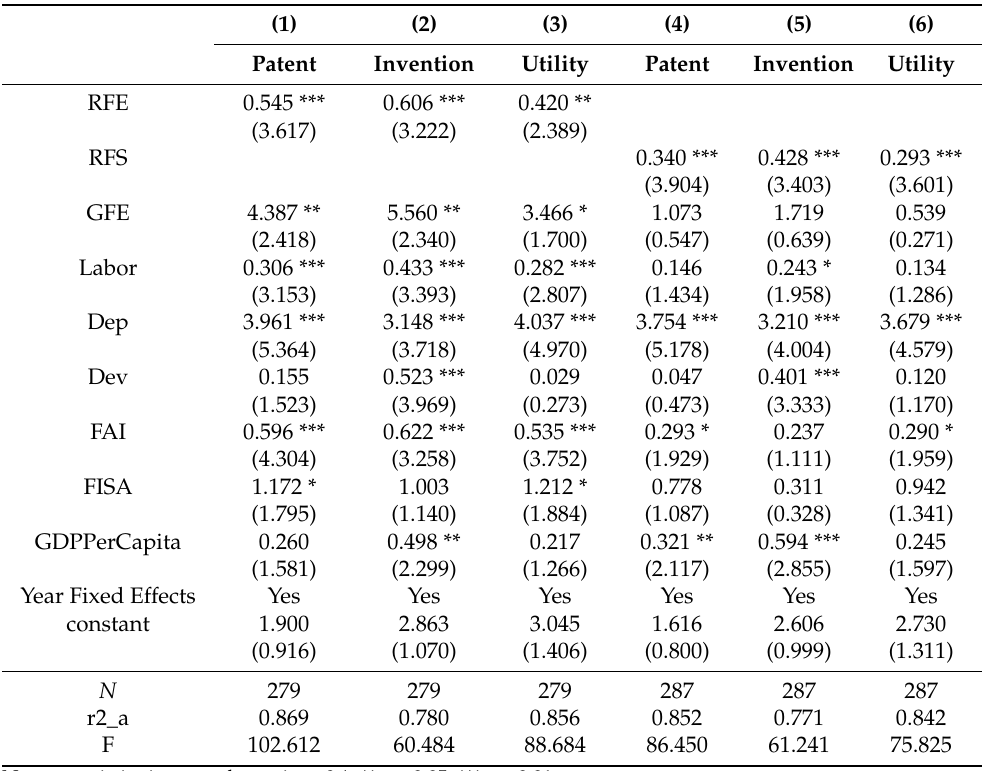
Table 3. Rural Financial Development and Agricultural Technology